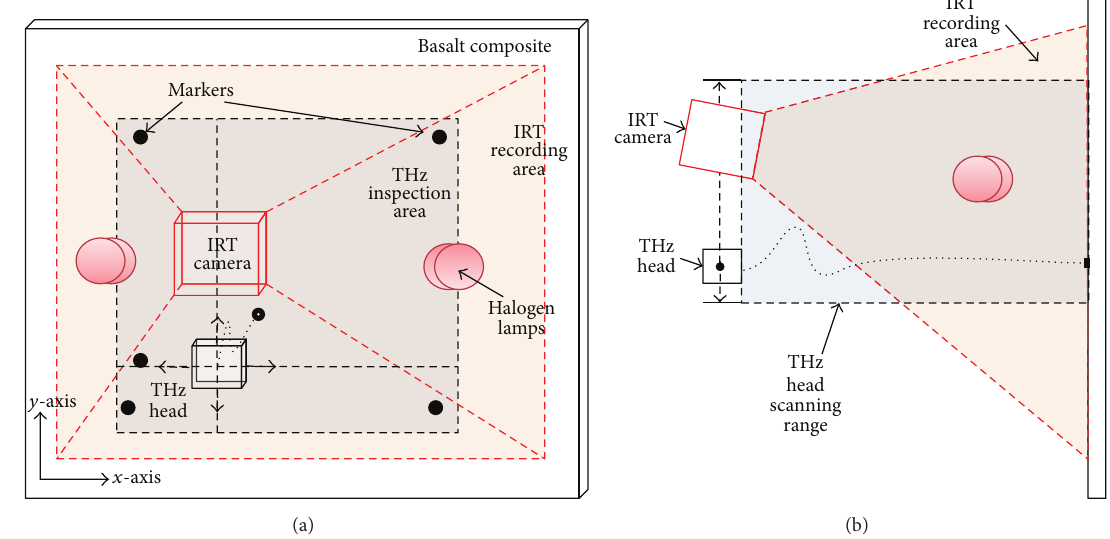
Figure 9: Schematic view of the experiments setup and spatial relationship between both methods sensing units: (a) top view and (b) side view.